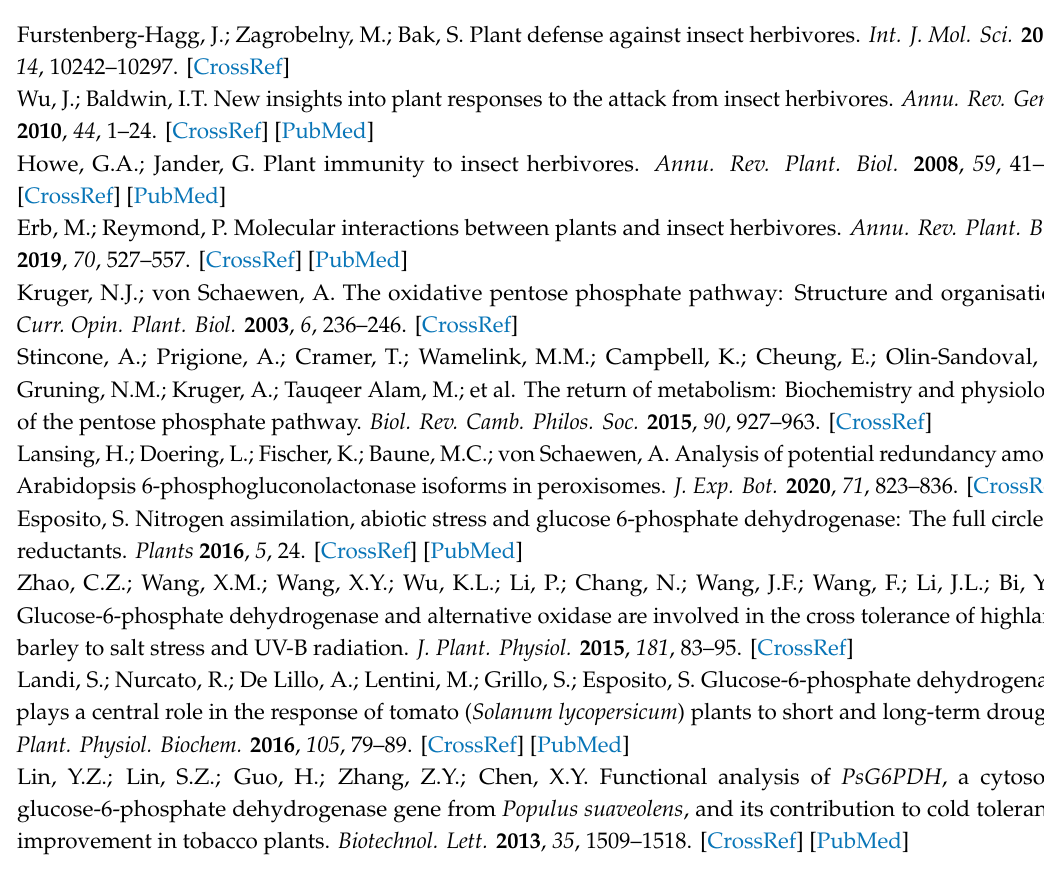
Figure S1. Gel electrophoresis of PCR amplified full-length segments of Os6PGDH1 from cDNA library of Xiushui 110. Figure S2. The nucleotide and deduced amino acid sequence of Os6PGDH1. Figure S3. Prediction of the conserved domains of Os6PGDH1. Figure S4. Levels of SA in oe6PGDH lines and WT plants at indicated time points after they were individually infested by 15 gravid BPH females. Figure S5. The survival rate of 15 newly hatched BPH nymphs that fed on oe6PGDH or WT plants. Figure S6. Construction of Os6PGDH1 -overexpression vector used for rice transformation. Figure S7. The experimental setup of BPH bioassay for feeding and